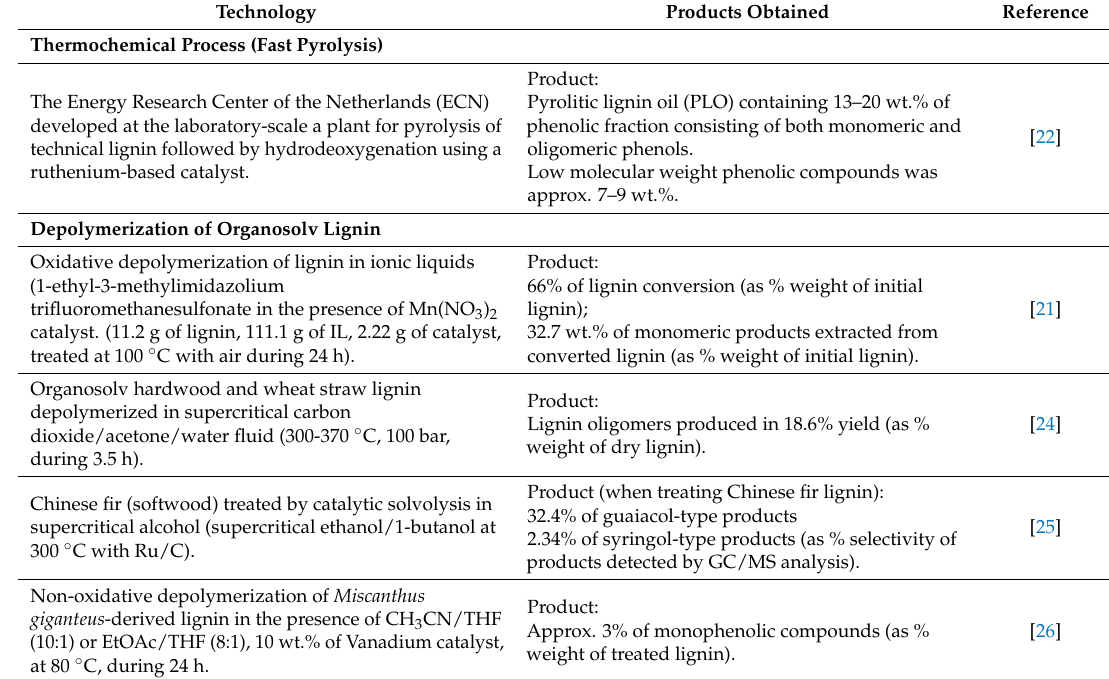
Table 1. Examples of chemical and physicochemical depolymerization processes converting lignin produced at an industrial level into low molecular mass aromatics. Technology Products Obtained Reference Thermochemical Process (Fast